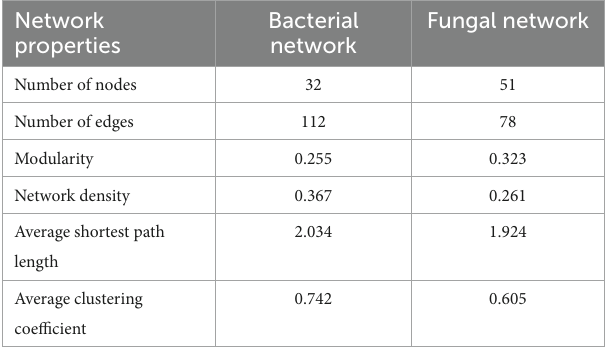
TABLE 3 Topological properties of communities in bacterial and fungal networks. Network